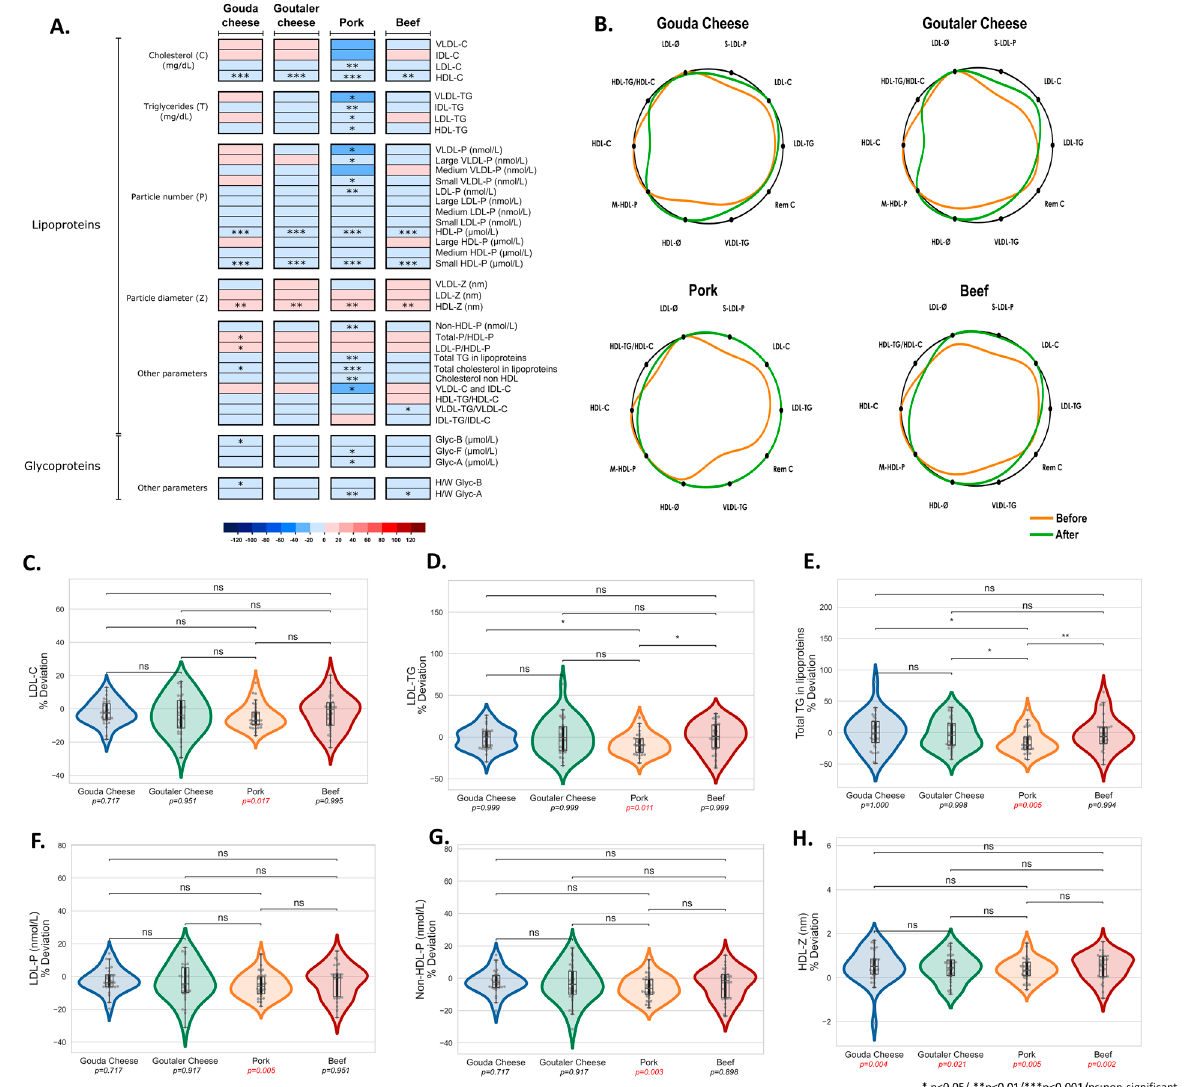
Figure 5. Heatmap representing lipoprotein profiles for the four different test diets (Gouda ‐ and Goutaler ‐ type cheeses, pork, and beef) ( A ); lipidic silhouette summarizing lipoprotein risk patterns for each test diet ( B ); comparisons between diets for LDL ‐ cholesterol ( C ), LDL ‐ TG ( D ), total TG in lipoproteins ( E ), LDL ‐ P ( F ), non ‐ HDL P ( G ), HDL particle diameter (HDL ‐ Z) ( H ).